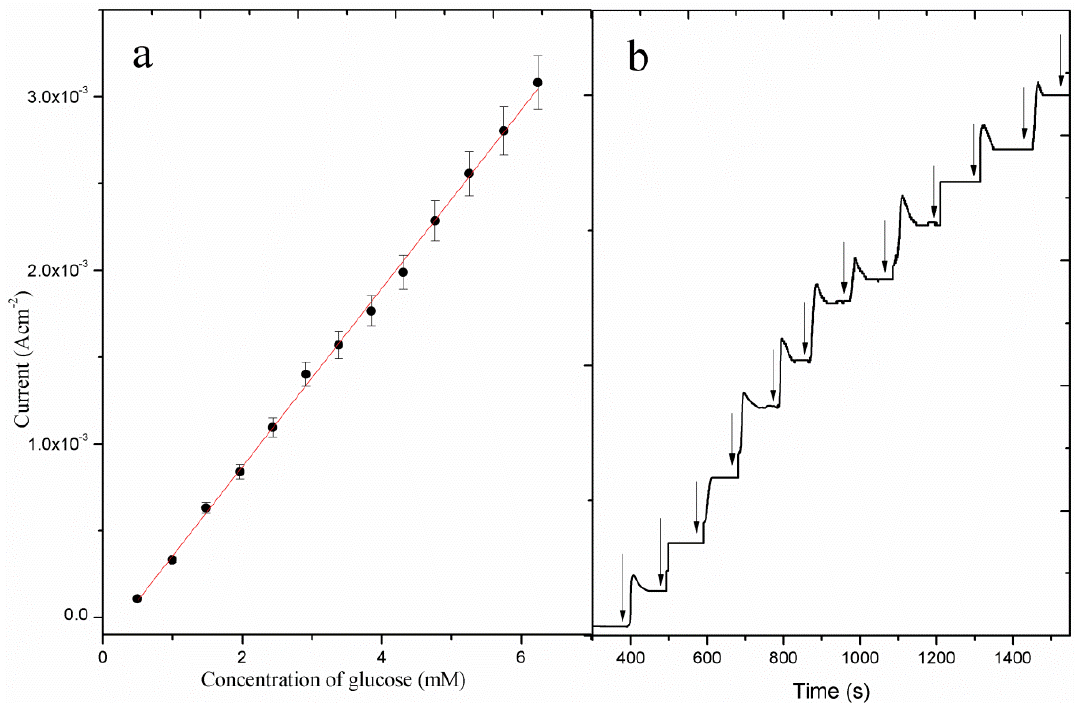
Figure 6. ( a ) The calibration curve of the current versus glucose concentrations by amperometric measurement at applied potential of 0.50 V; ( b ) The response time curve of the proposed glucose sensor at applied potential of 0.50 V with successive addition of glucose in 0.10 M NaOH